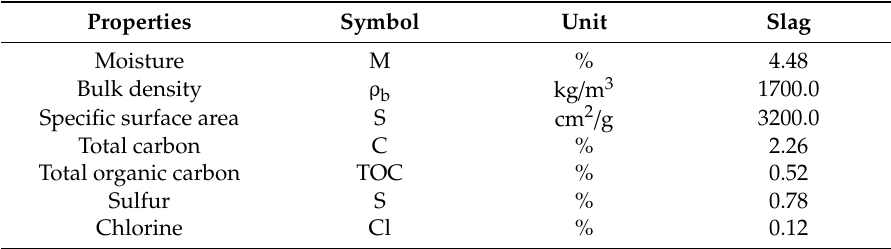
Table 5. Basic technical properties of tested